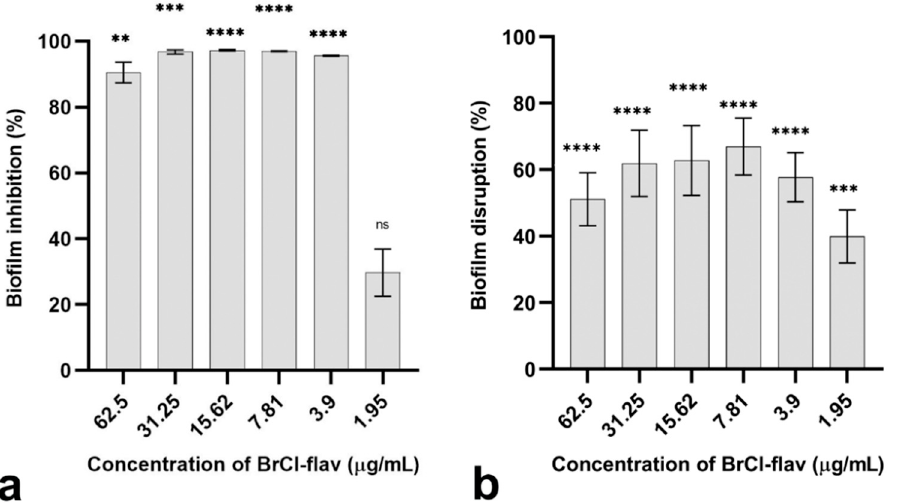
Figure 4. The effects of the BrCl-flav on A. baumannii medbio3-2013 biofilms: ( a ) inhibition of biofilm formation (bacterial cells were incubated for 24 h in the presence of BrCl-flav); ( b ) disruption of mature biofilms (before exposure to BrCl-flav, the biofilms were pre-formed for 24 h). Values are the means of at least three replicates. Bars indicate SEM. Asterisks represent a significant difference ( p < 0.05) vs. Control (** = p < 0.01, *** = p < 0.001, **** = p < 0.0001; ns—non-significant).